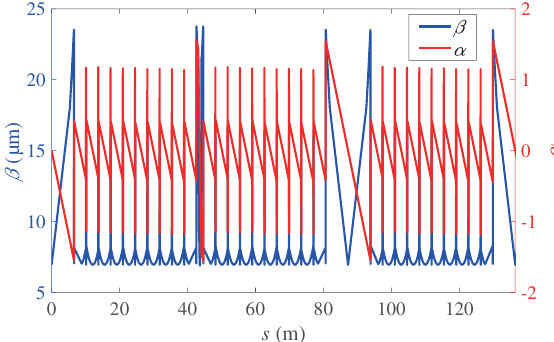
FIG. 16. Longitudinal Twiss functions of the half ring in Table